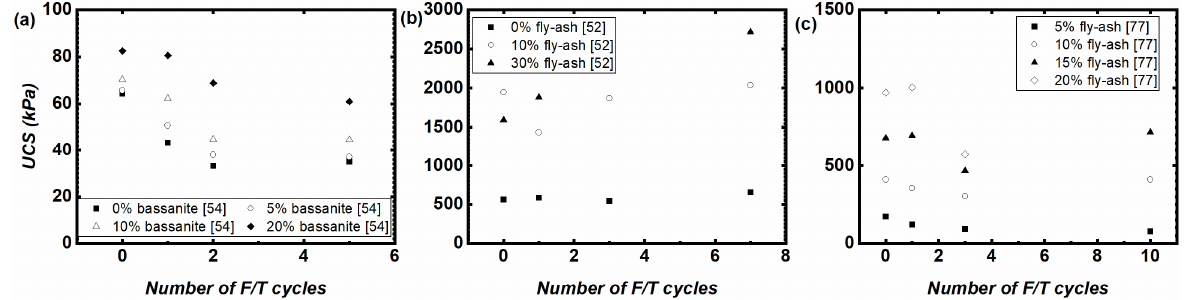
Figure 6. The effect of binders on the performance of soilcrete subjected to F/T cycles: ( a ) UCS of soilcrete subjected to F/T cycles with varying bassanite content [52], ( b ) UCS of soilcrete subjected to F/T cycles with varying fly ash content [50], ( c ) UCS of soilcrete subjected to F/T cycles with varying bentonite and fly ash content [76].